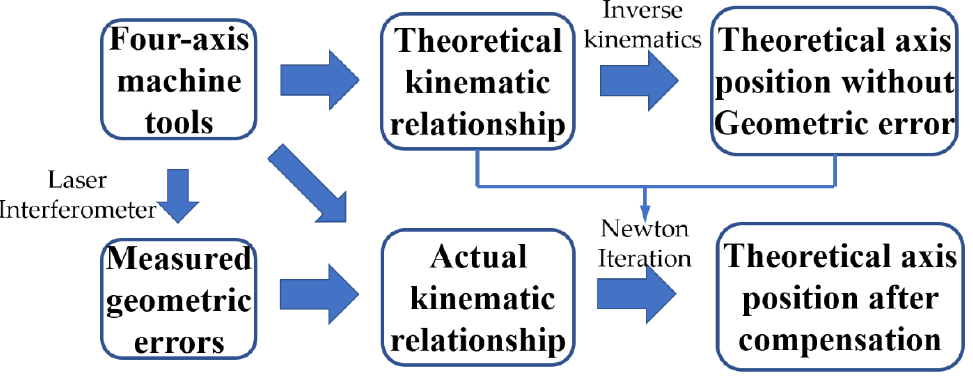
Figure 1. The flowchart of the proposed method.